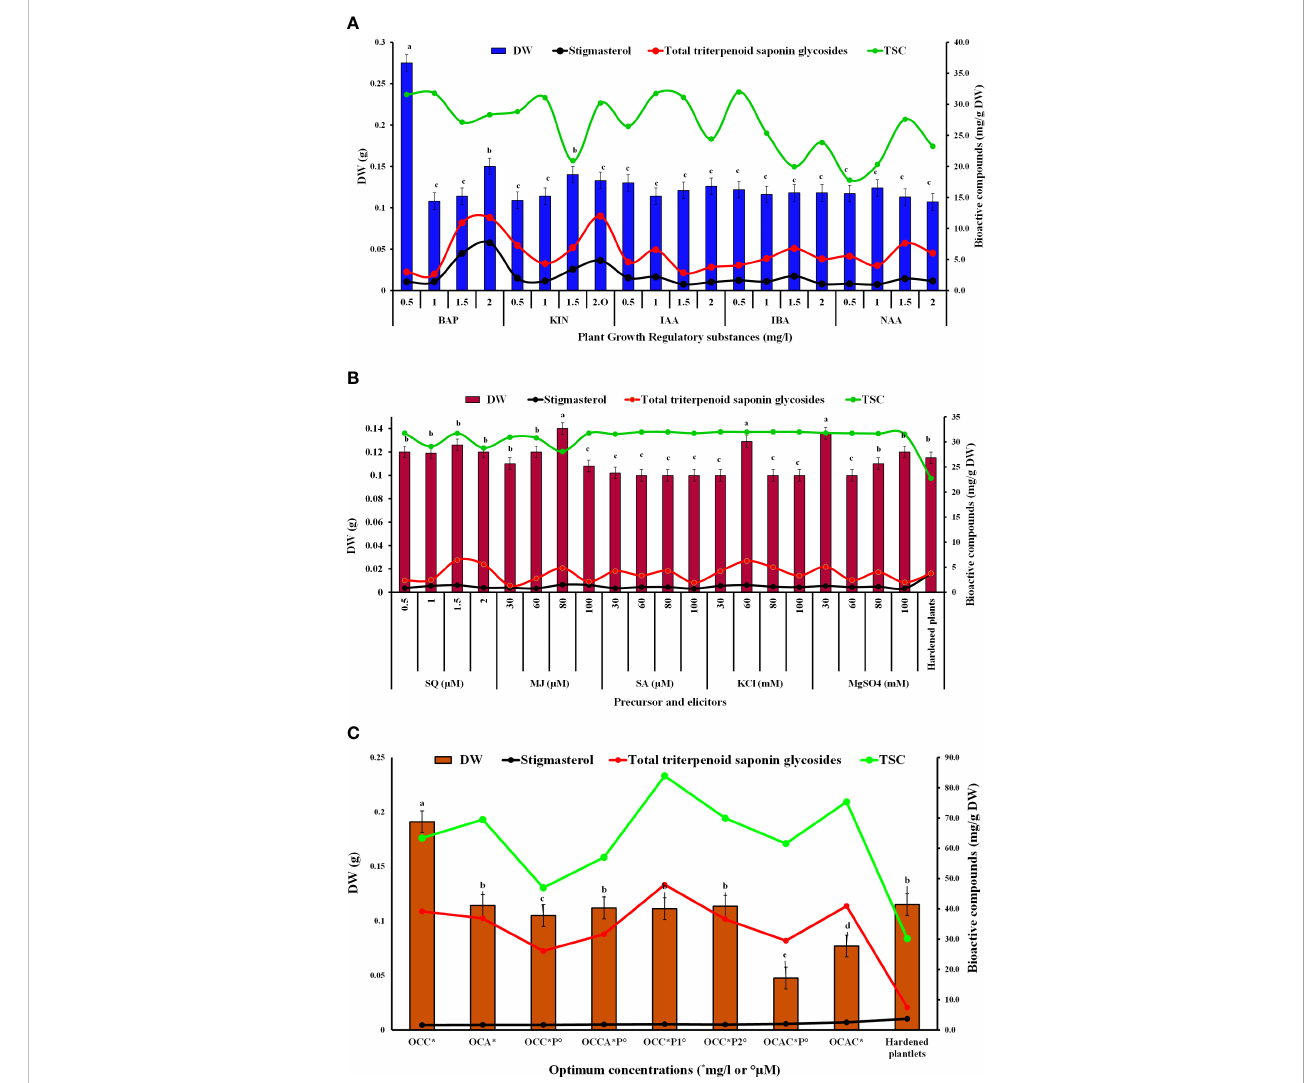
FIGURE 2 Effects of different PGRs (A) , precursor and elicitors (B) , and their optimal combinations (C) on dry weight, total saponins, total triterpenoid saponin glycosides, and stigmasterol contents from in vitro grown biomass of B. fl oribunda